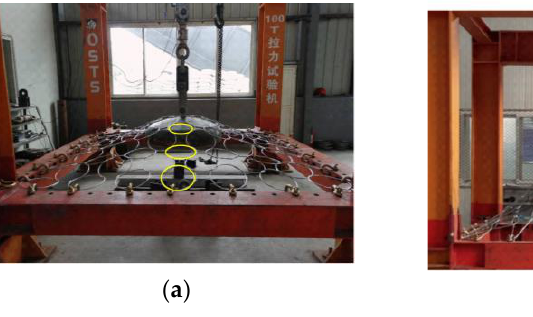
Figure 4. Test process: ( a ) ring net tightening; ( b ) ring deformation before breakage; ( c ) ring net after broken.